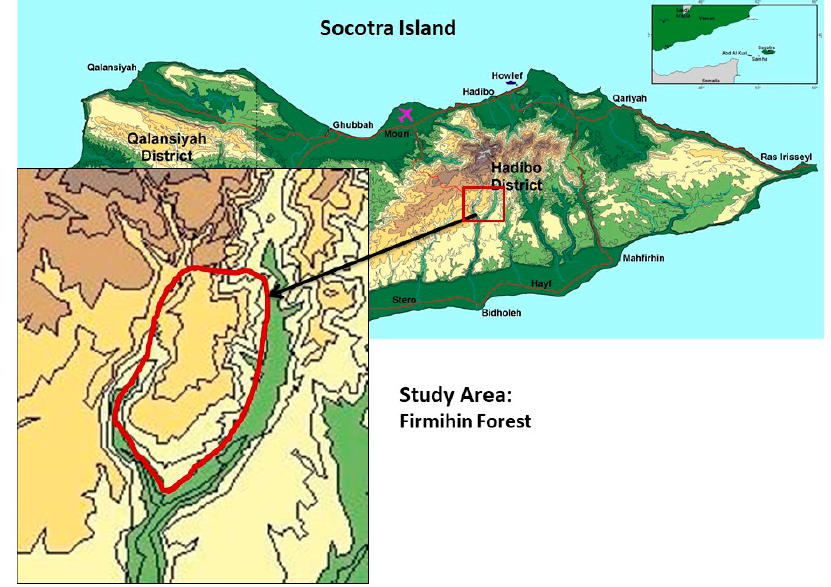
Figure 1. Location of the study area (adapted from master plan EPC (Environment Protection Council), MoPD (Ministry of Planning and Development), and MoHCUP (Ministry of Housing, Construction and Urban Planning) Republic of Yemen).